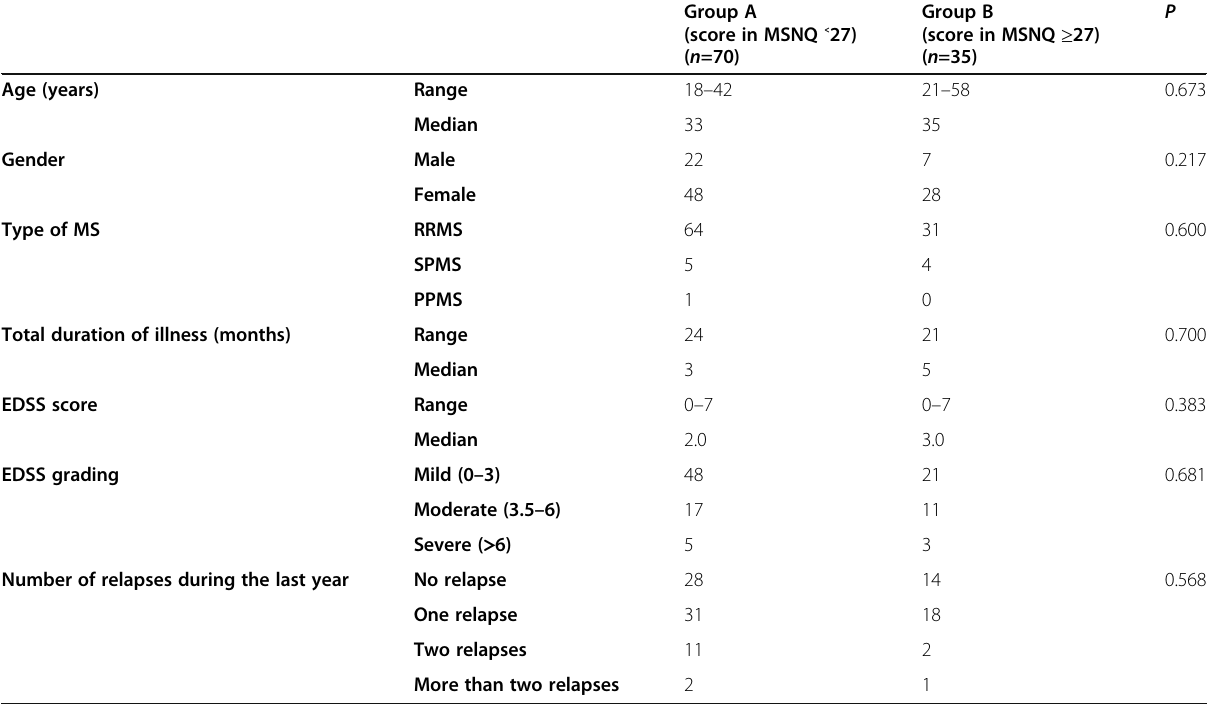
Table 4 Comparison among study population according to the MSNQ score